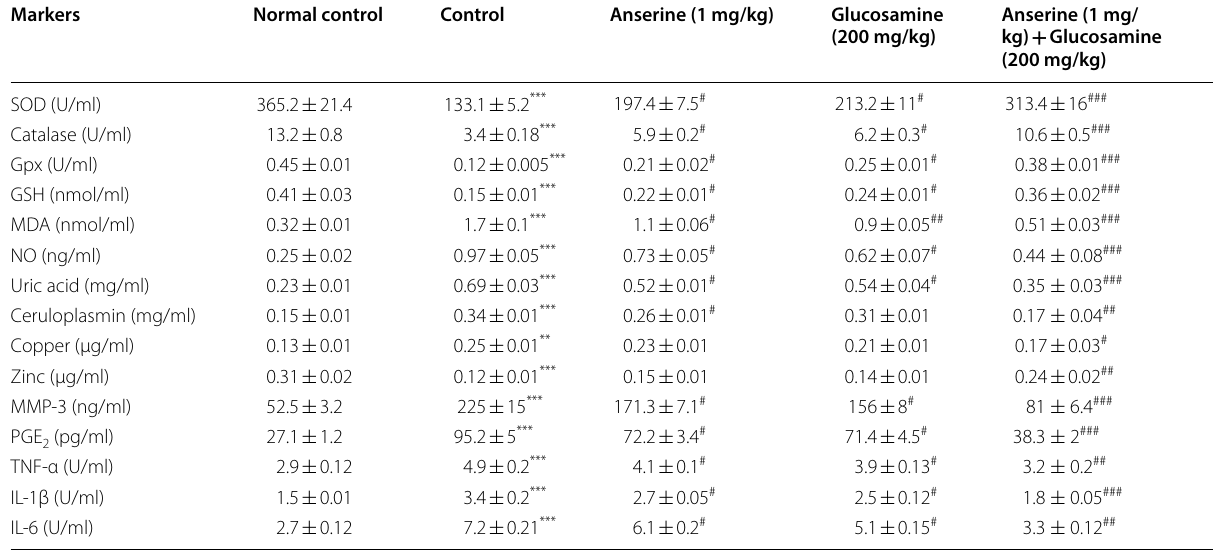
*** P < 0.001, # P < 0.05, ## P < 0.05 and ### P < 0.05